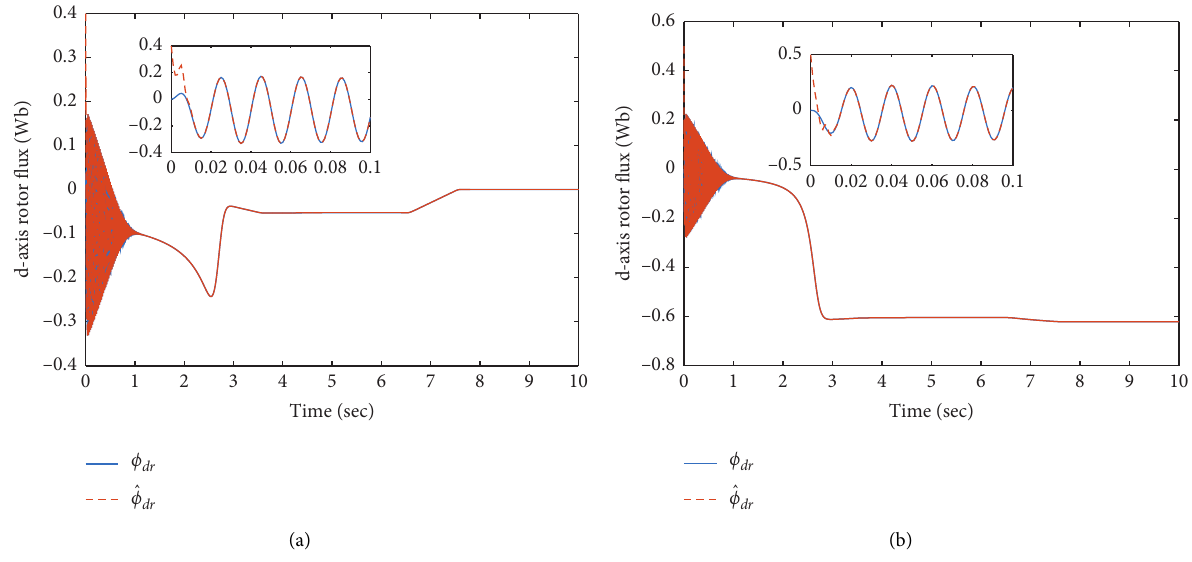
Figure 2: Evolution of ϕ dr and ϕ qr versus their estimates provided by (15).